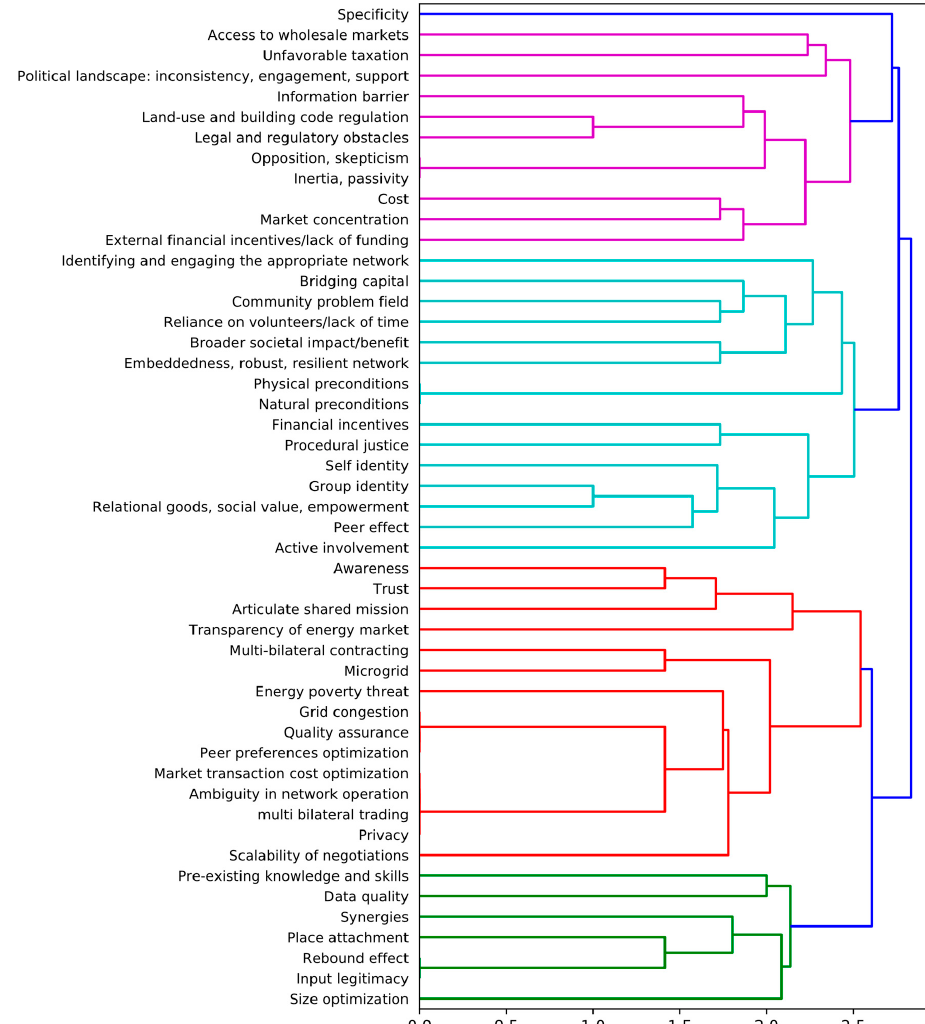
Figure 17. Progression factor distribution by lifecycle phase.